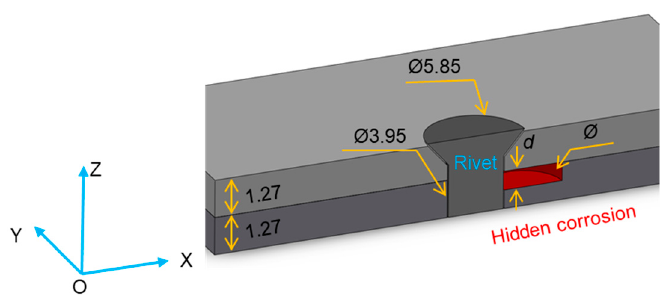
Figure 3. Two-layer specimen with a rivet with hidden corrosion on the second layer.